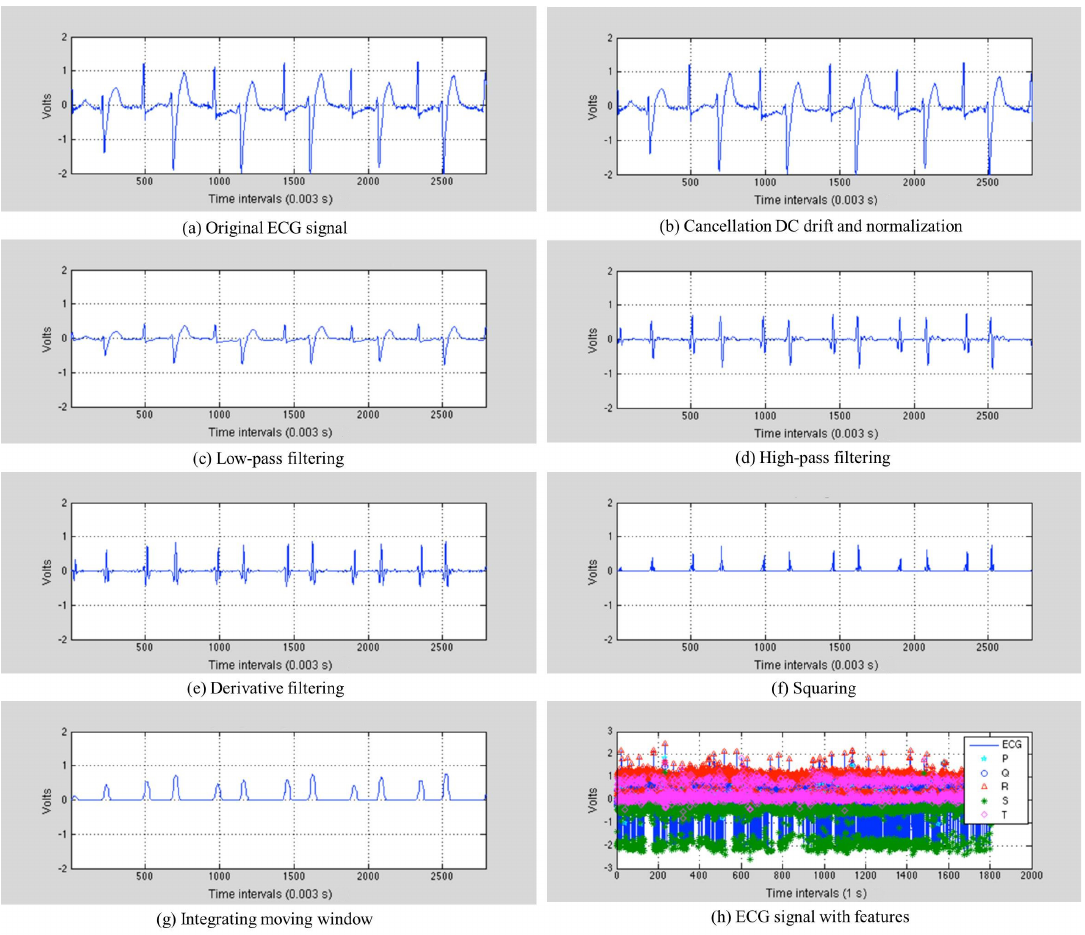
Figure 5. Results of feature extraction with step-by-step output of the Pan–Tompkins